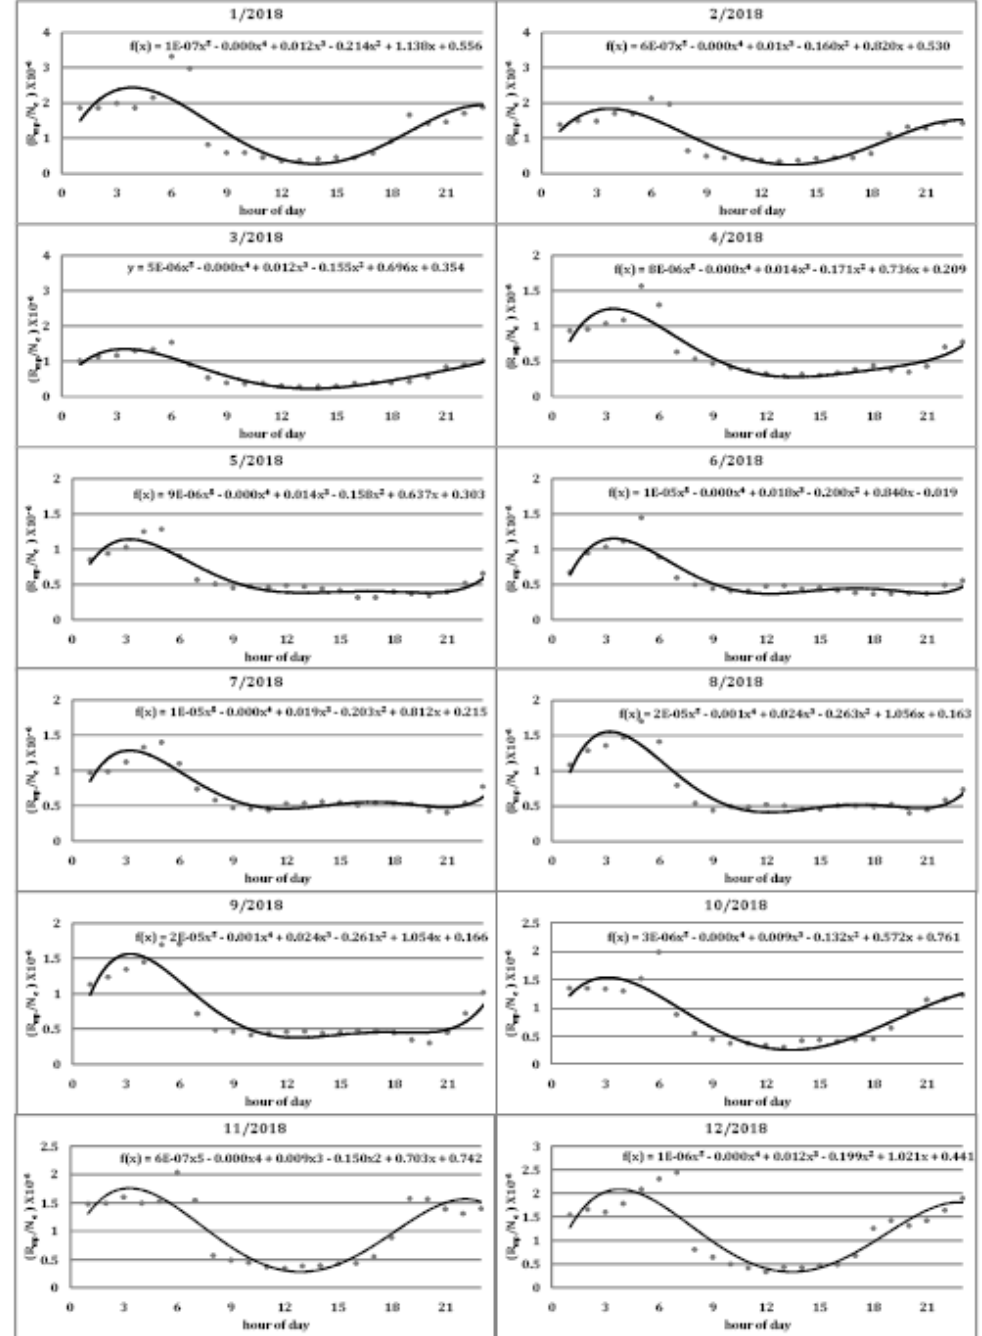
Fig. 11: Monthly median of (Rmp /Ne) for year